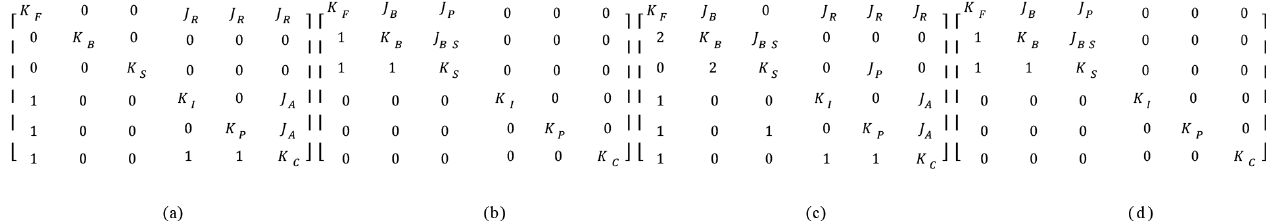
Figure 4. Topological matrix of the original crossbow.